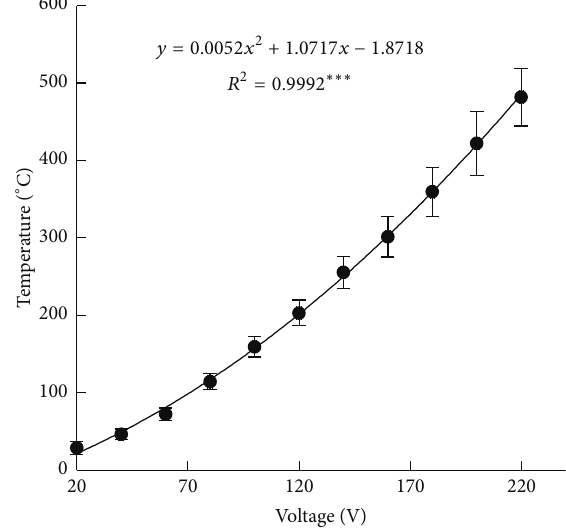
Figure 1: Relationship between input voltage and epiradiator sur- face temperature. Mean and standard deviation of 10 measurements per voltage